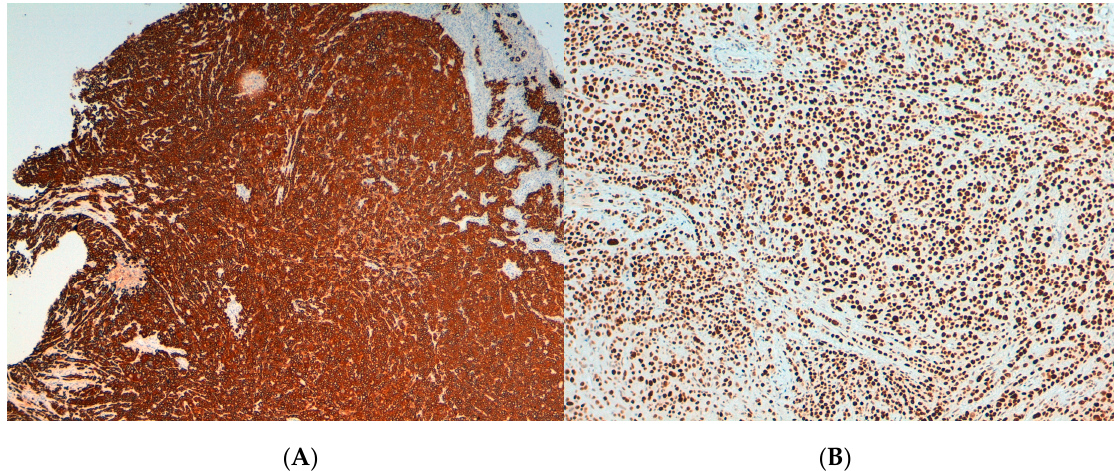
Figure 2. Microphotographs showing the immunohistochemical staining of the endocervical mass compatible with poorly differentiated squamous carcinoma. ( A ) MNF116: positive ( B ) MSH2: positive.